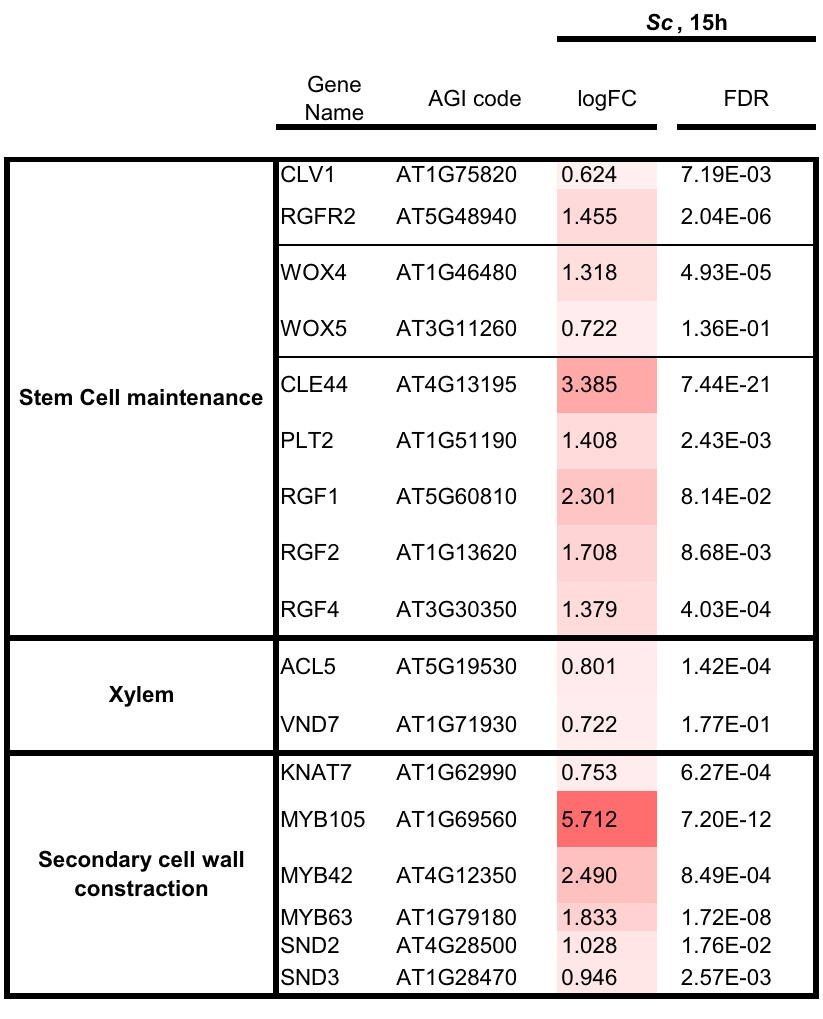
Table 2. The genes associated with stem cell formation, xylem development, and the secondary cell wall were up-relulated in Arabidopsis seedlings treated with Sc extract or Hormone mixture, compared with in Rhus